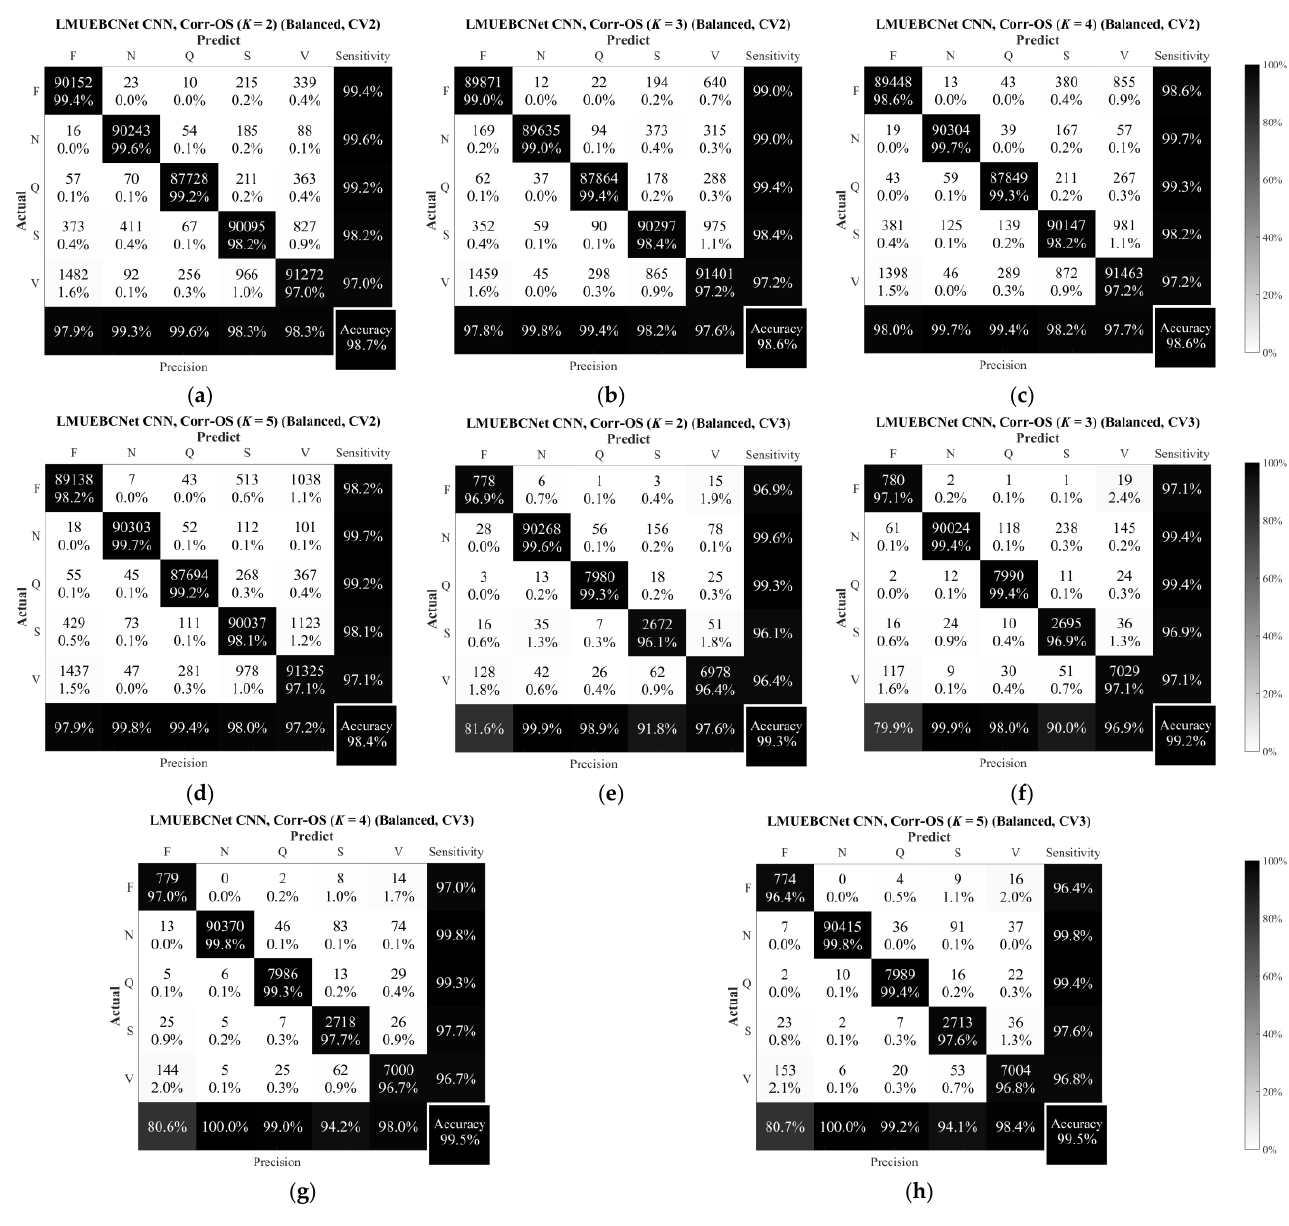
Figure A5. Confusion matrix of LMUEBCNet using CV2 for ( a ) Corr-OS ( K = 2), ( b ) Corr-OS ( K = 3), ( c ) Corr-OS ( K = 4), and ( d ) Corr-OS ( K = 5); using CV3 for ( e ) Corr-OS ( K = 2), ( f ) Corr-OS ( K = 3), ( g ) Corr-OS ( K = 4), and ( h ) Corr-OS ( K = 5).